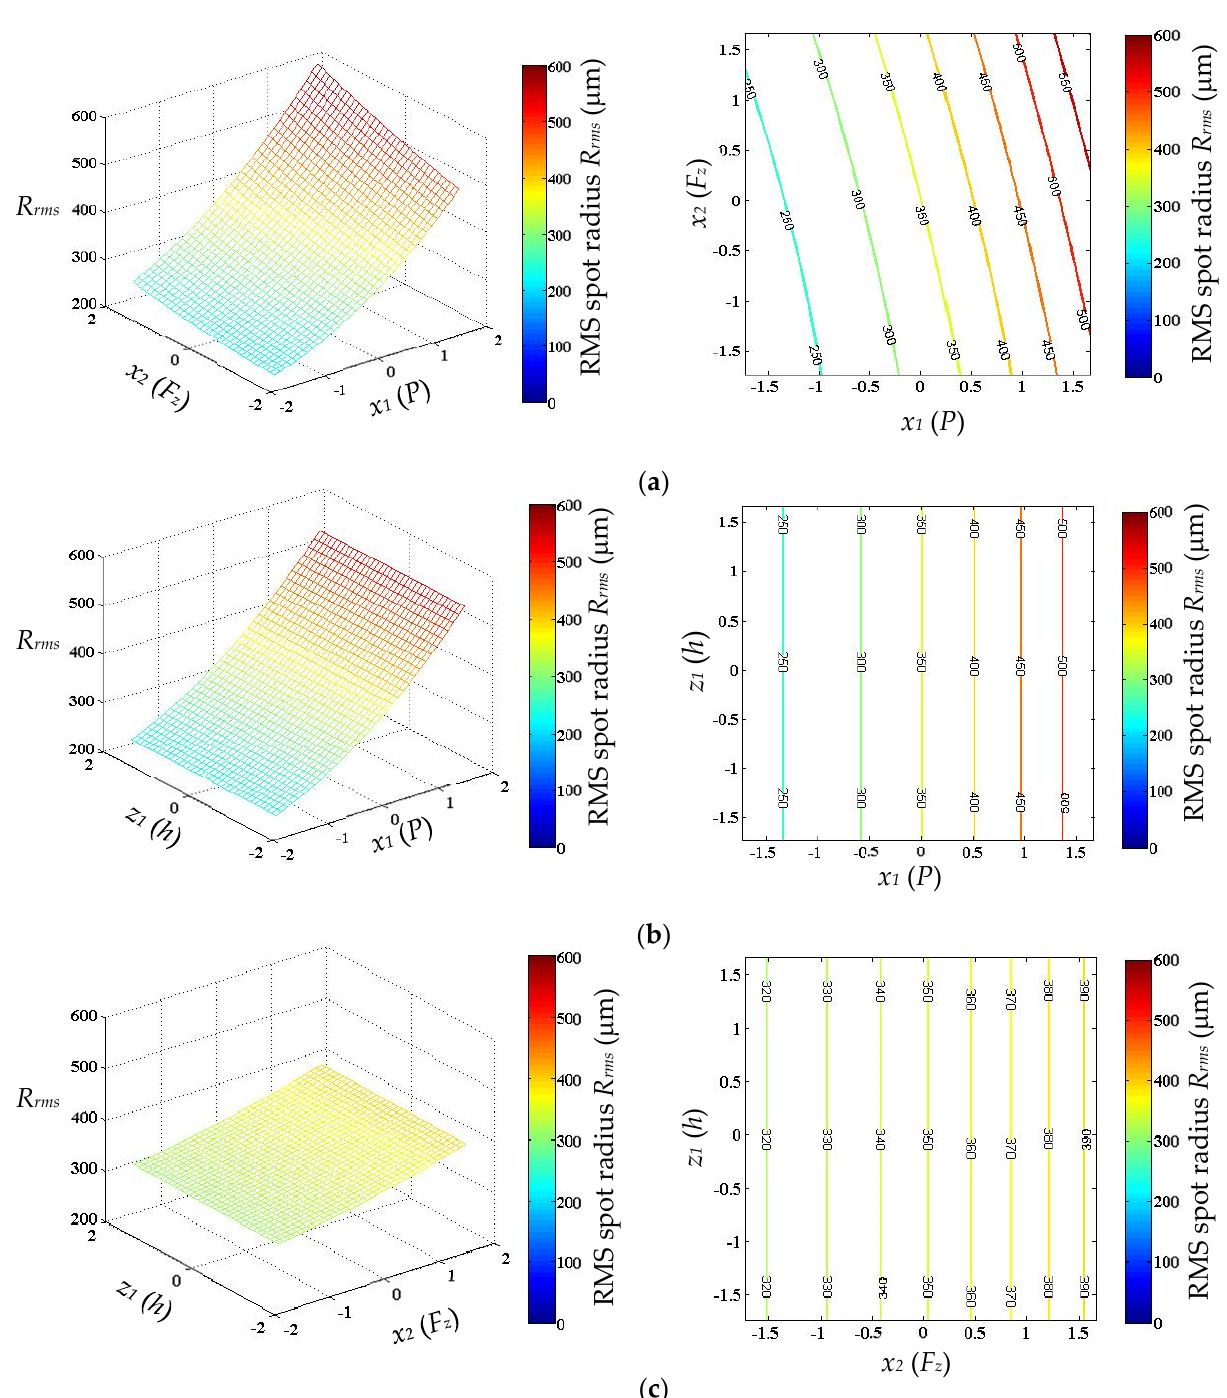
Figure 12. Response surfaces and contours of RMS spot radius R rms as the function of any two variables among x 1 , x 2 , and z 1 : ( a ) R rms ( x 1 , x 2 ), ( b ) R rms ( x 1 , z 1 ), and ( c ) R rms ( x 2 , z 1 ).